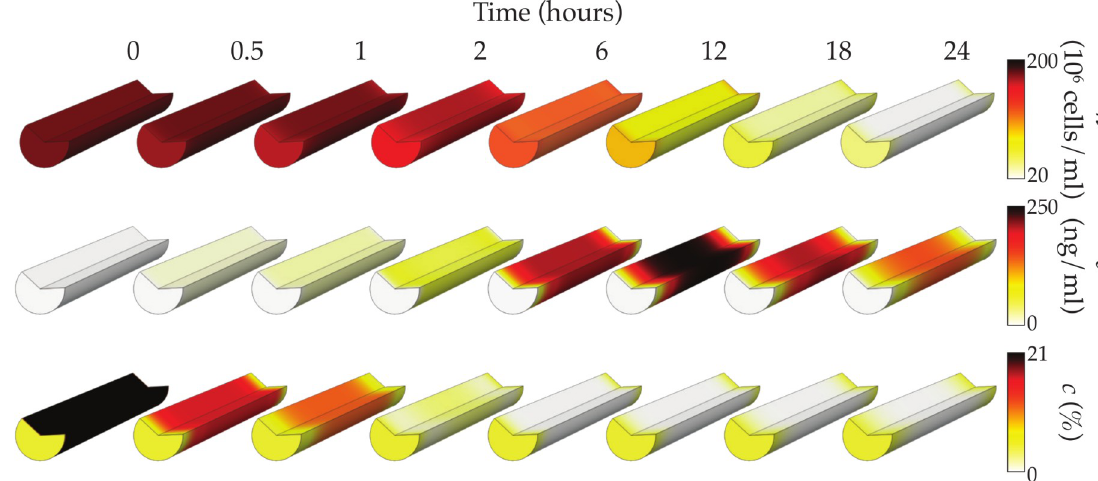
Fig 2. Cell-solute interactions in an impermeable nerve repair construct result in non-uniform distributions of cells, oxygen and VEGF. Heatmaps of cell density, oxygen and VEGF concentration over 24 hours for an initial cell density n 0 = 1.78 × 10 8 cells/ml. Only the collagen gel cylindrical core is displayed as the surrounding sheath is